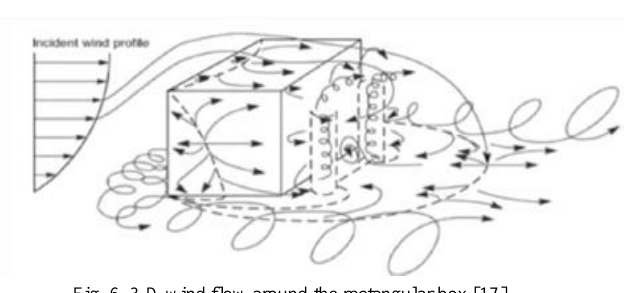
Fig. 6. 3-D wind flow around the rectangular box